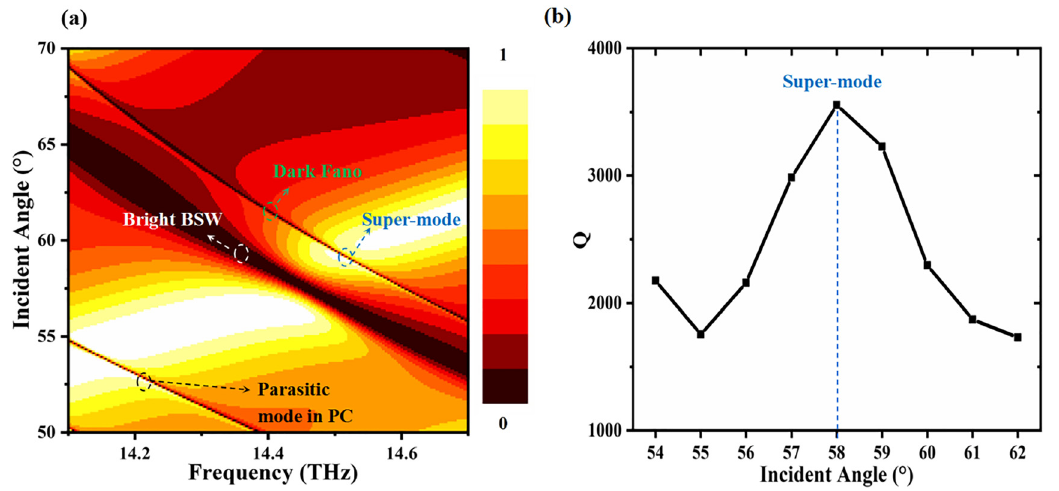
Figure 3: (a) Transmission spectrum as a function of the incident angle of the Bloch surface wave (BSW) structure. The quasi-bound states in the continuum (BIC) mode are highlighted by dotted circles colored with blue, it is related to the eigenstate that is embedded in a continuum, see the bright yellow region. Notice bright BSW and dark Fano modes are respectively highlighted by dotted circles colored with white and green. Besides, there exists a parasitic mode that is embedded in photonics crystal (PC) layers. (b) The relationship between Q value of dark Fano mode and incident angle, with an operation frequency as 14.58 THz. Note the parasitic mode in PC is caused by destructive interference that occurred in the PC layers, it may also belong to quasi-FW-BICs. However, since the electric fi eld is mainly extended within PC layers, such mode is useless for sensing